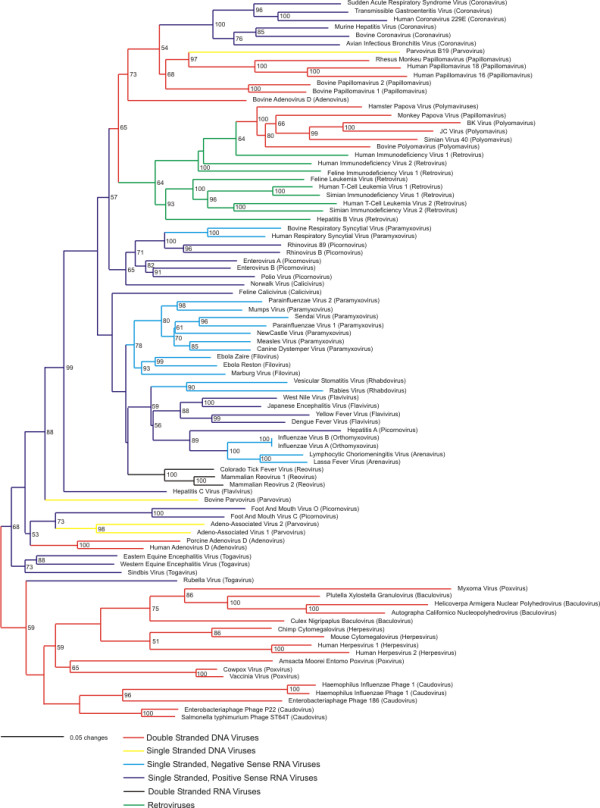
Phylogram of 90 selected viruses for which genomic sequences are available. The organisms were grouped by using distance matrices based on the sums differences from the other organisms for the 256 tetranucleotide combinations, as described in Materials and Methods. Phylogenies were created by neighbor-joining analysis. Colors indicate double stranded DNA viruses (red); single stranded DNA viruses (yellow); retroviruses (green); negative-sense single stranded RNA viruses (blue); positive-sense single stranded RNA viruses (sky blue); and double stranded RNA viruses (black). Bootstrap values >50 based on 100 replicates are represented at each node, and branch length index is indicated below the phylogeny.